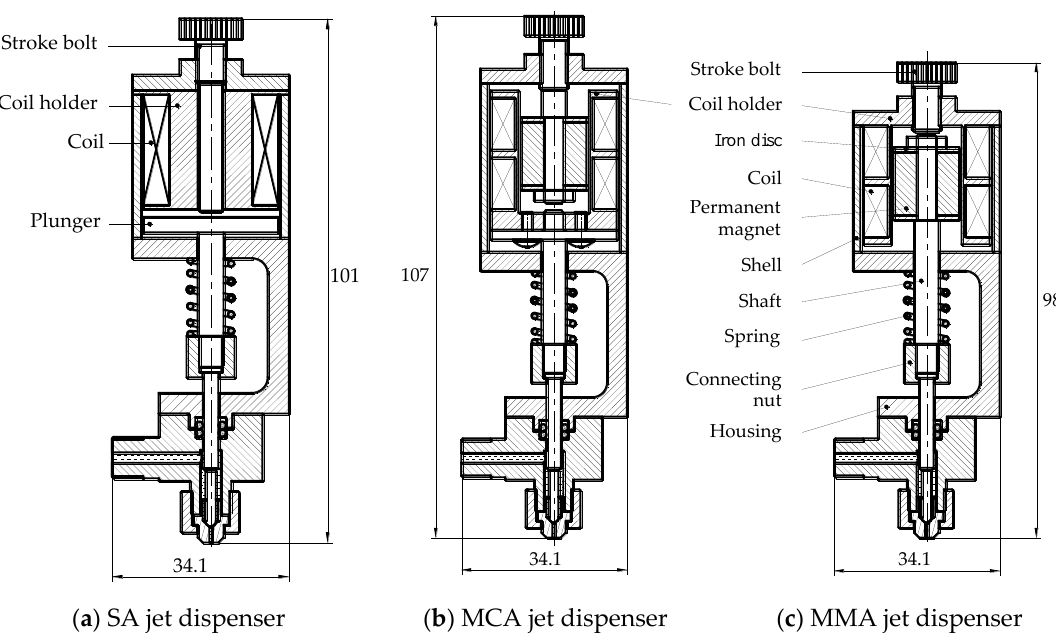
Figure 16. Dispenser configuration of jet dispensers based on proposed actuators.